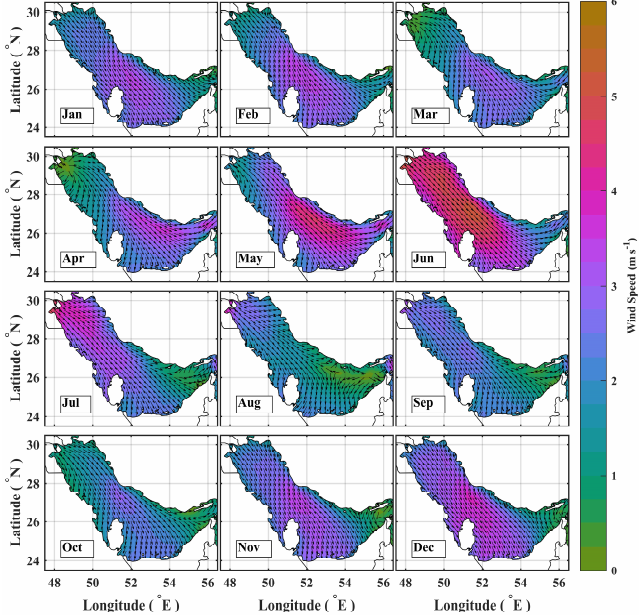
Figure 2. Intra − annual cycle of wind speed (1993 − 2020). Figure 2. Intra-annual cycle of wind speed (1993 −